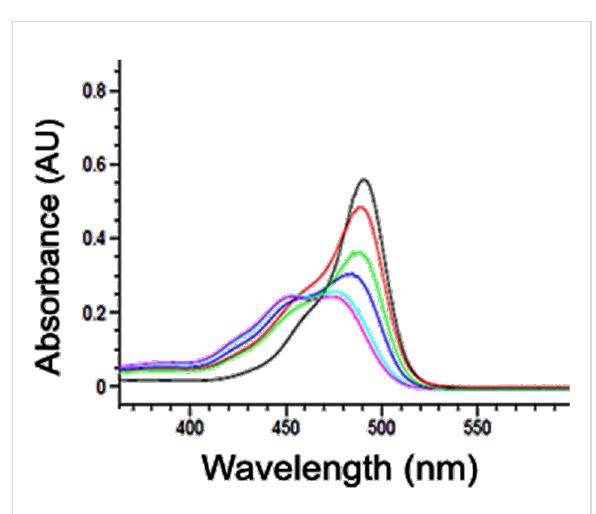
Figure 7: UV–vis spectrum of fluorescein with increasing amounts of hyper-branched β -CD polymer. pH range: 8.4–7.2.